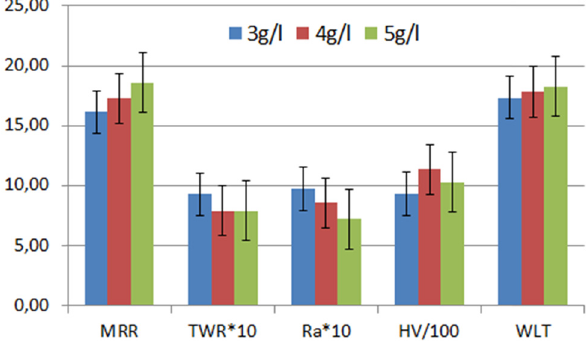
Figure 5: E ff ect of titanium powder concentration on performance